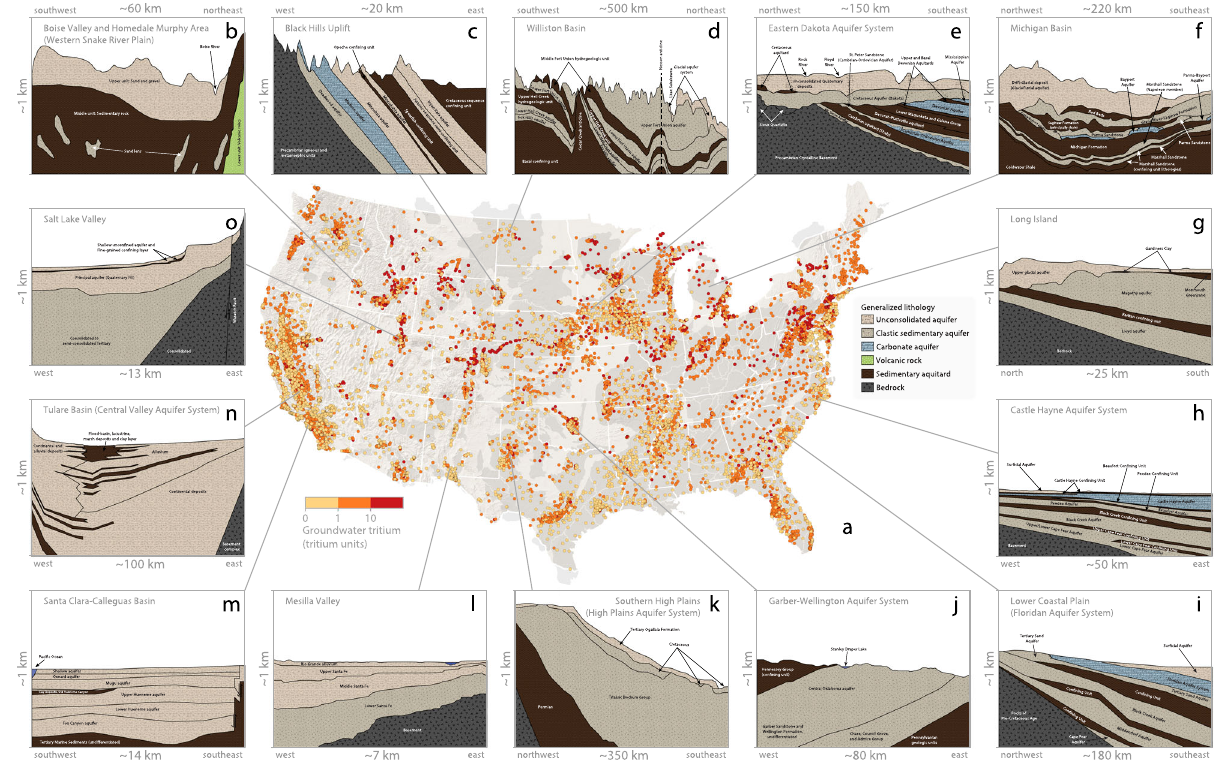
Fig. 1 | Well water tritium ( 3 H) measurements across the contiguous United States.a Lightyellowshadesrepresentlowertritiumactivities(below1tritiumunit), orange shades represent mid-range tritium activities (1 – 10 tritium units) and red shadesrepresentwellwaterswithhightritiumactivities(exceeding10tritiumunits;1 tritiumunitis~0.118Bq/L).Lightgreypolygonsunderlyingtheyellow-redpointsare aquifersystemboundariespublishedbyGebreEgziabheretal.(ref.19;dataavailable via https://www.hydroshare.org/resource/d2260651b51044d0b5cb2d293d21af08/). b – o display hydrostratigraphy via cross-sections for n =14 of the n =74 aquifer systems that we studied. The presented cross-sections are based on fi gures and lithologic descriptions presented for the b Boise Valley and Homedale Area within